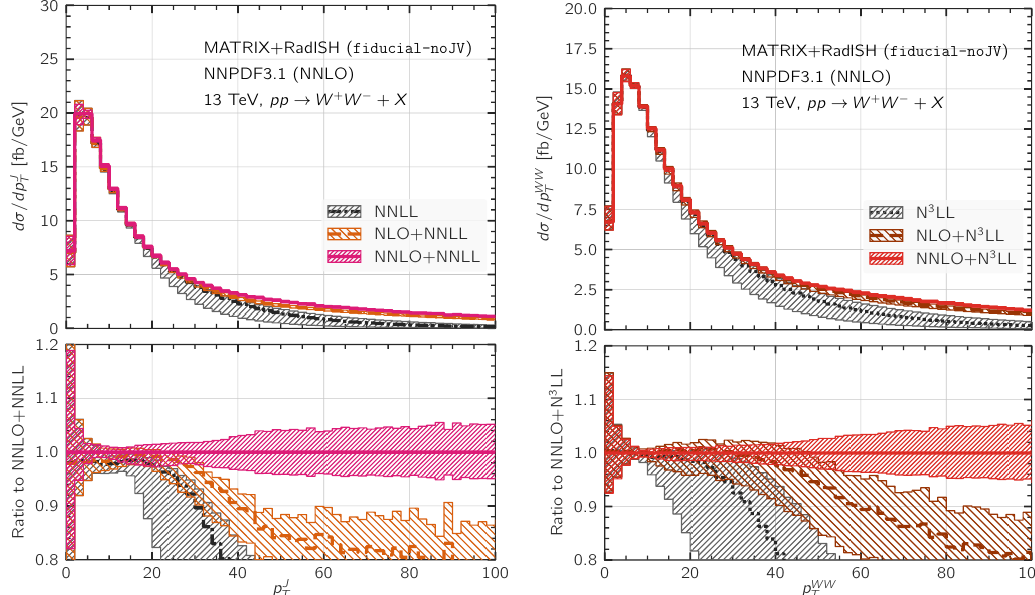
Figure 7 . Left plot: transverse-momentum spectrum of the leading jet in the fiducial-noJV phase space comparing predictions at NNLO+NNLL (magenta, solid), NLO+NNLL (ochre, dashed) and NNLL (black, dot-dashed) accuracy. The lower frame shows the ratios of the predictions to the central value of the NNLO+NNLL result. Right plot: transverse-momentum spectrum of the W + W − pair in the fiducial-noJV phase space comparing predictions at NNLO+N 3 LL (red, solid), NLO+N 3 LL (brown, dashed) and N 3 LL (black, dotted) accuracy (right plot). The lower frame shows the ratios of the predictions to the central value of the NNLO+N 3 LL